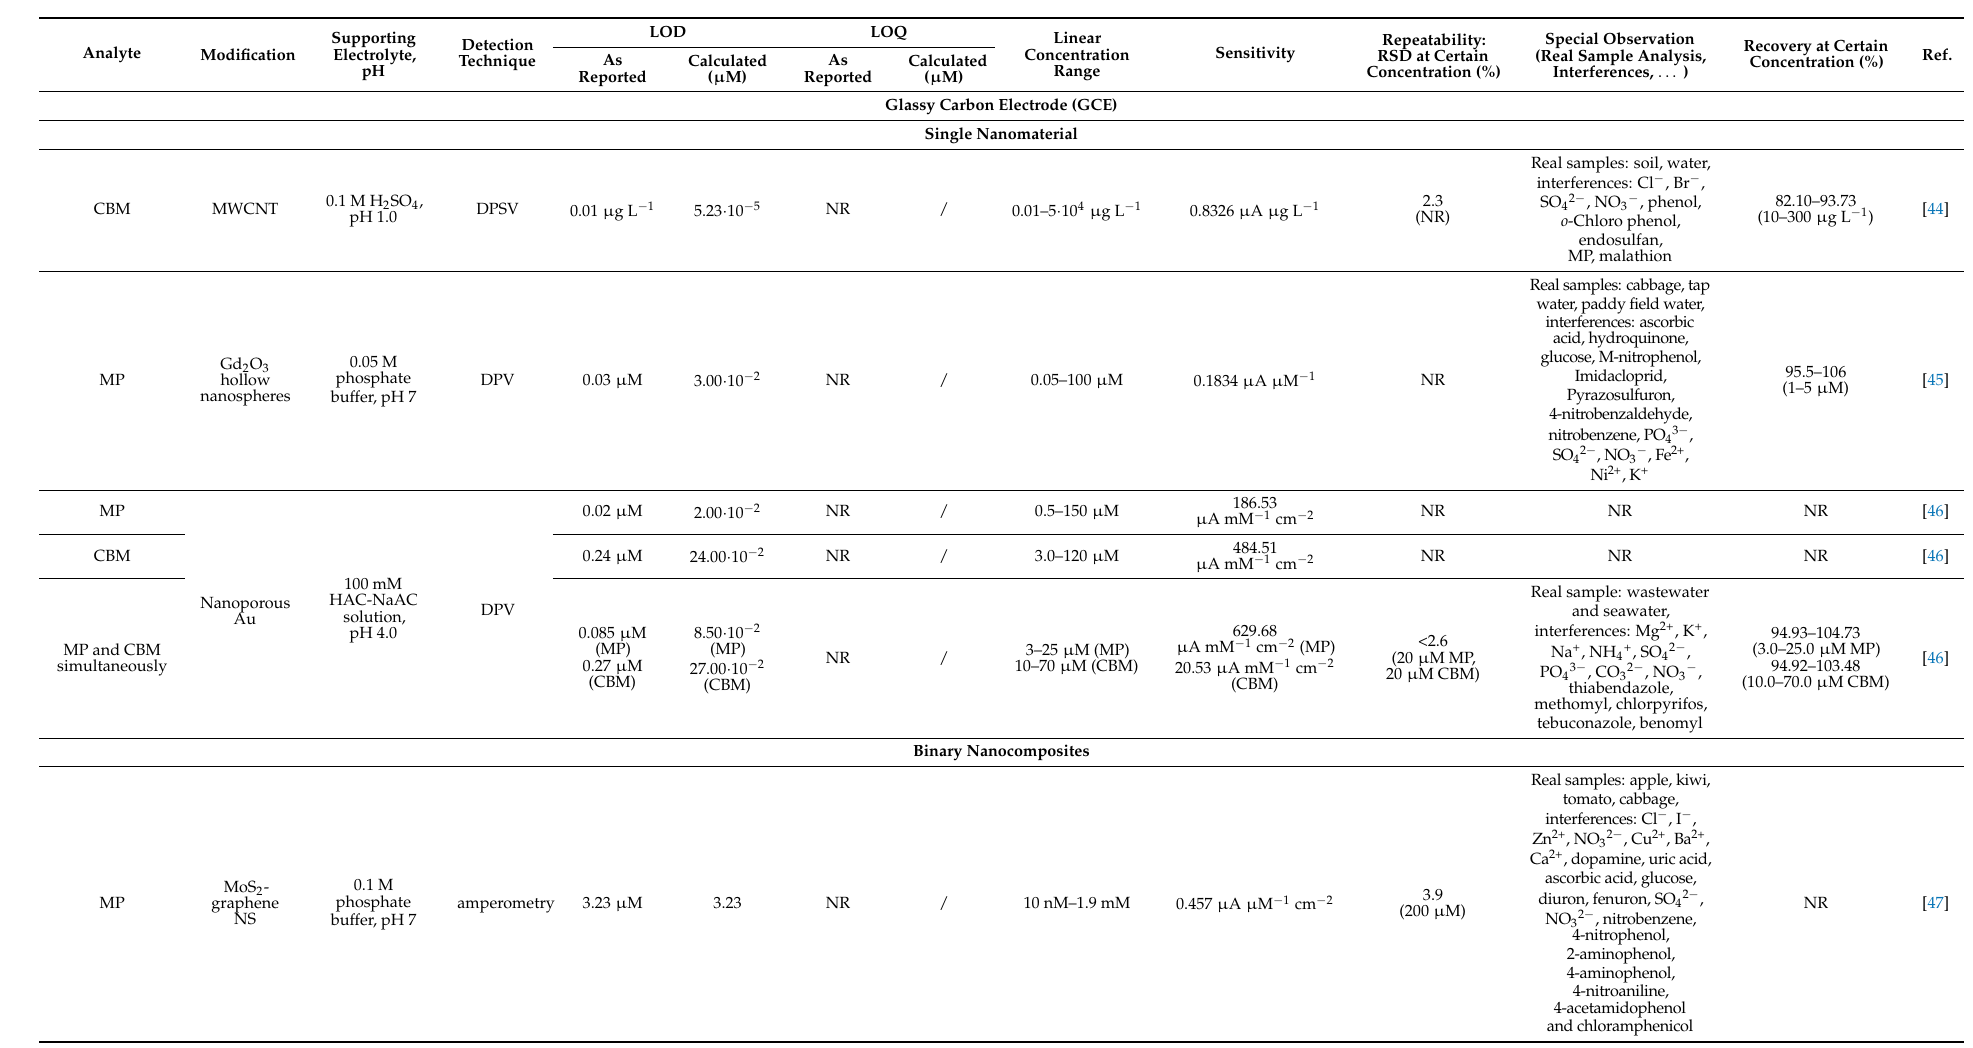
Table 1. Summary of validation parameters for non-enzymatic electrochemical sensors using modified GCEs for pesticide detection. Repeatability is reported as RSD (in %) at a given concentration of the analyte. The recovery determined in real sample analysis is given from the minimum to the maximum values as reported.